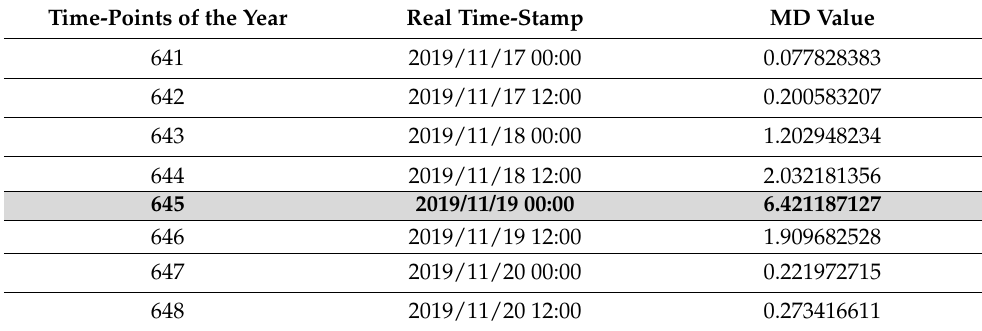
Table 4. Detailed MD value and timestamp list around the SCADA alarm region for H11. Time-Points of the